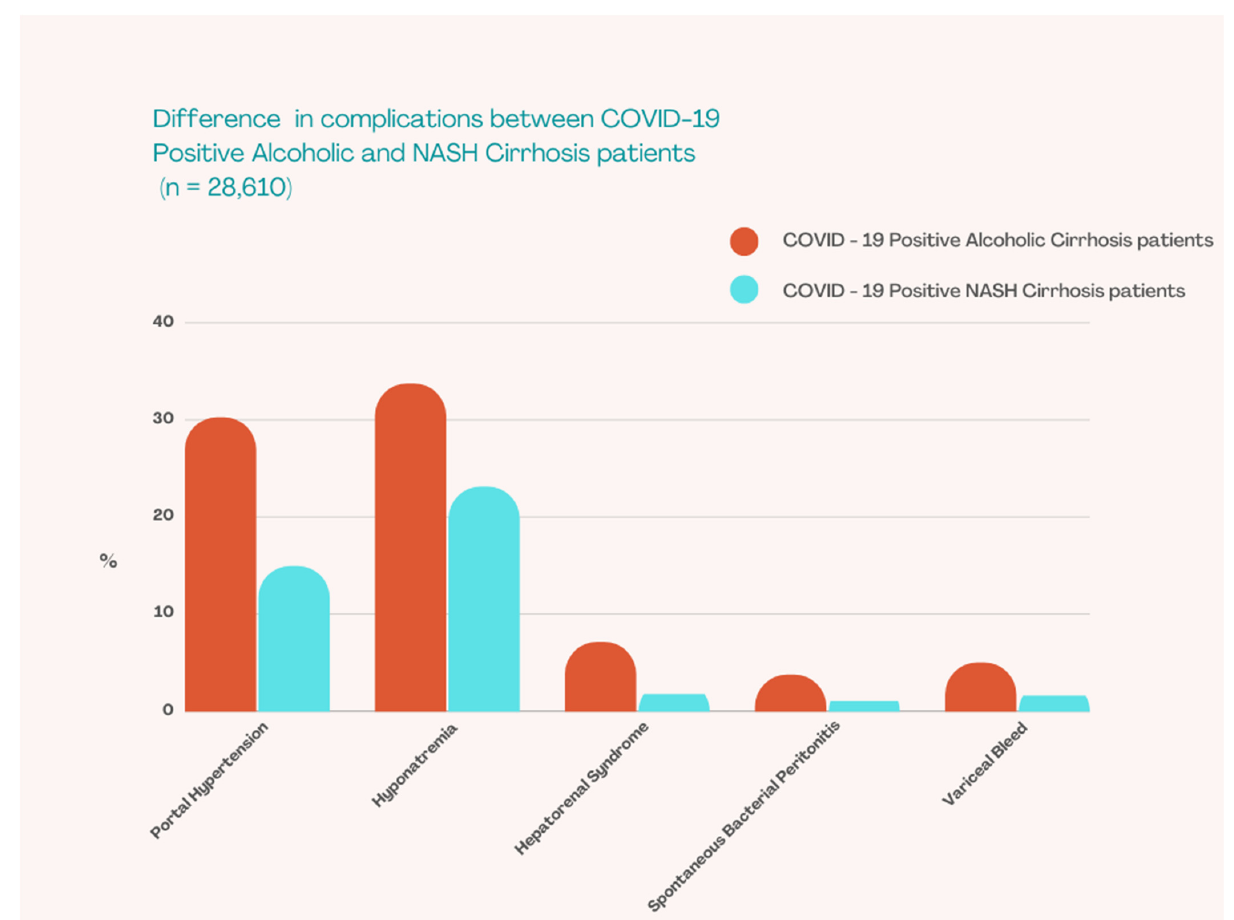
Figure 2. Difference in complications between COVID-19 positive alcoholic and NASH Cirrhosis patients. Table 3. Sub-group analysis of COVID + Alcoholic and NASH Cirrhosis